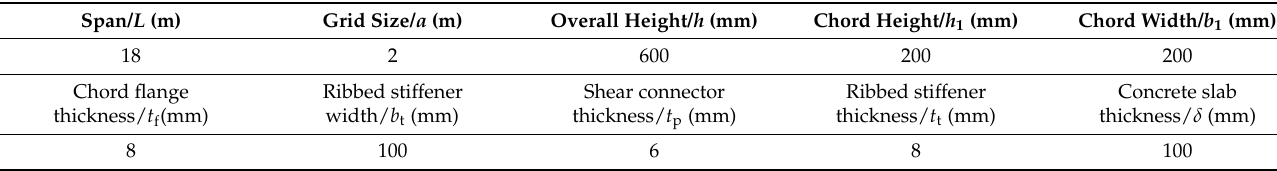
Figure 2. Structural size diagram: ( a ) plane layout; ( b ) structural details. Table 2. Basic parameters of model structure.